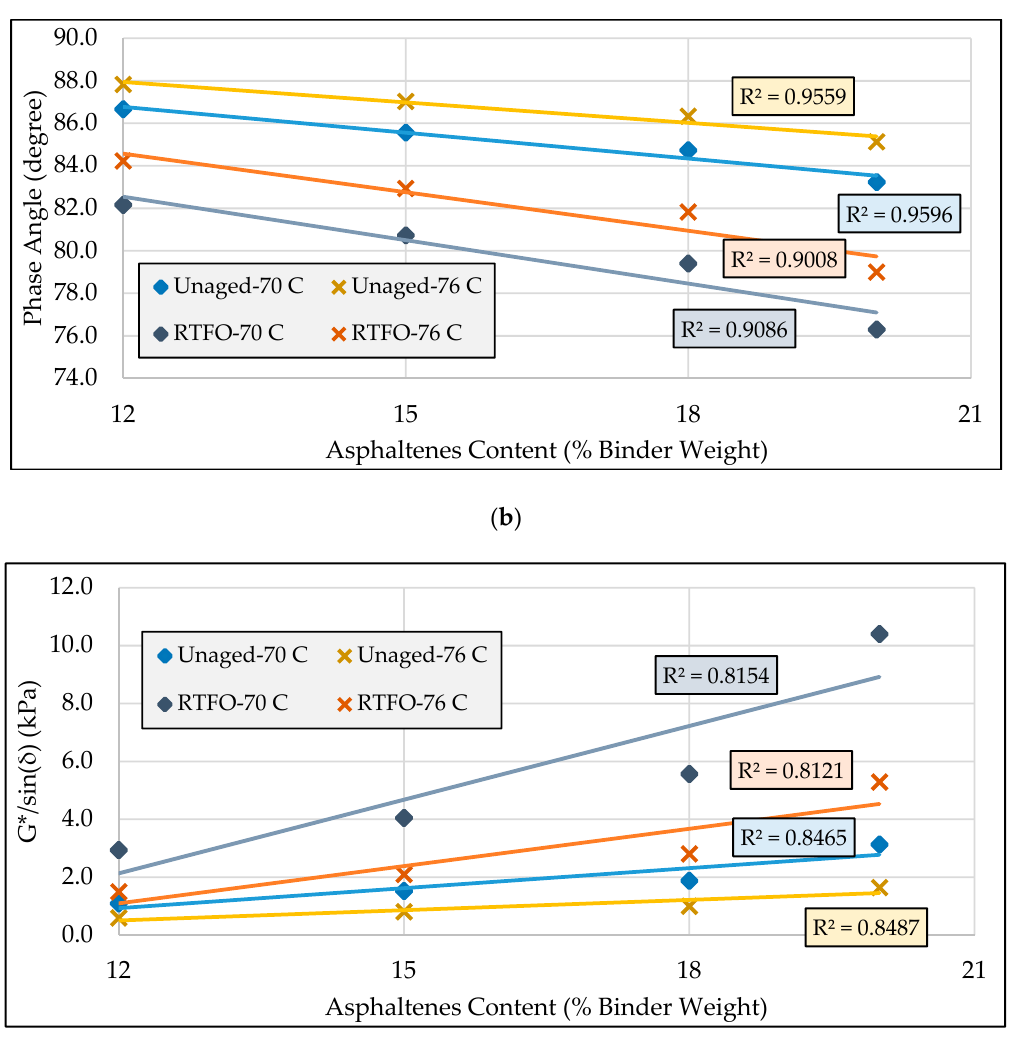
Figure 4. Comparison of rheological properties of the second group of modified binders: ( a ) complex shear modulus; ( b ) phase angle; ( c ) rutting factor.